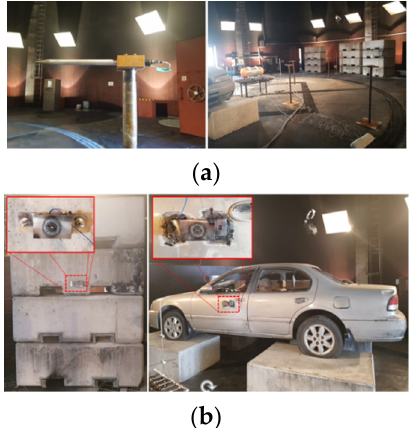
Figure 3. Sensors installed for the experiment: ( a ) incident pressure sensor ; ( b ) reflect pressure Figure 2. Hydrogen tank and heating source: ( a ) hydrogen tank (type Ⅳ ); ( b ) heating source. sensor .